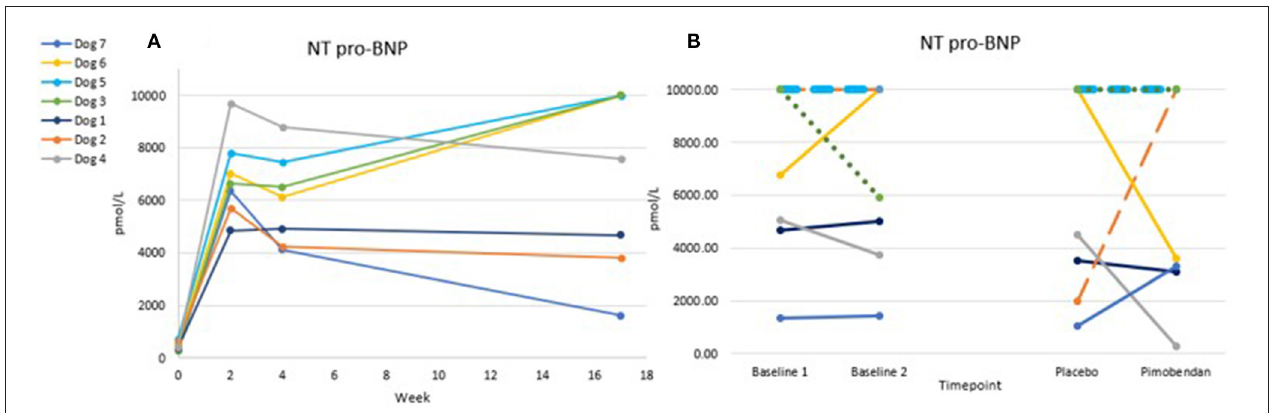
FIGURE 5 | Chart (A) shows trends of NT pro-BNP over time from baseline through tachypacing. Chart (B) shows the variability in this value from Baseline 1 to Baseline 2 (1 week apart) and the timepoint 3h after oral dosing. Lines are dashed due to overlap. No significant difference was found between pimobendan and placebo p =